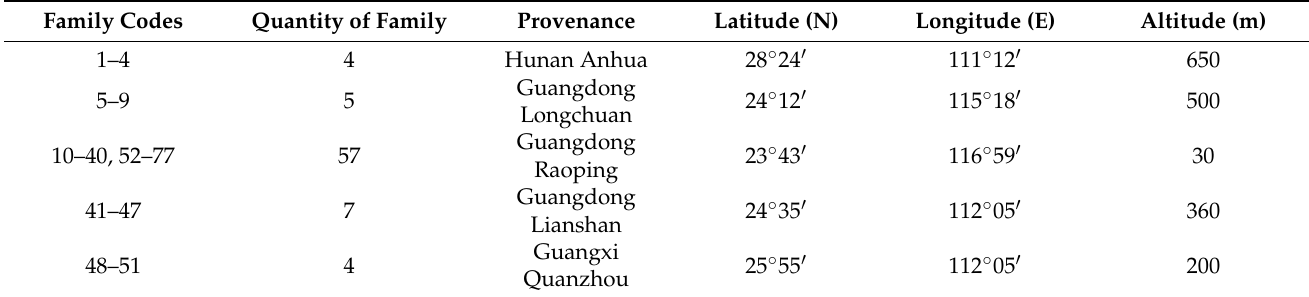
Table 2. The provenances and families sourced in the